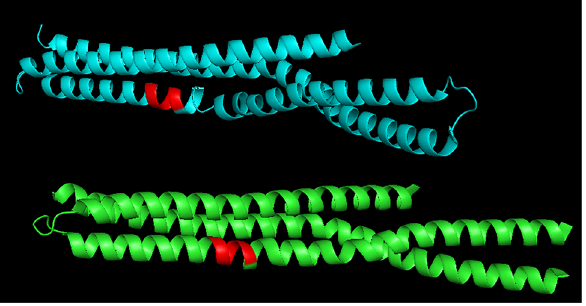
Figure 3: PDB entry 2FIC: the BAR domain of the human Bin1/amphiphysin II, depicted with PyMol. The red col- ored sections of the 𝛼 -helices correspond to the HQKLV